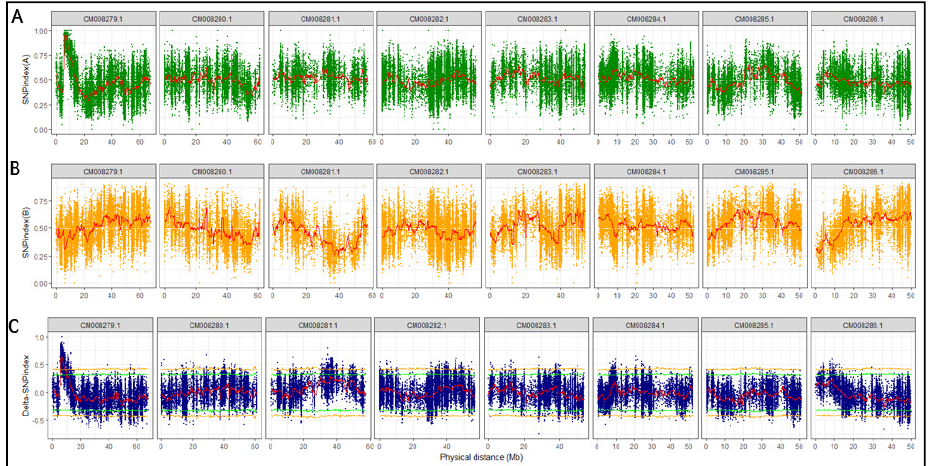
Figure 3. SNP-index plot: ( A ) the top panel is the plot of SNP-index for K21; ( B ) the middle panel is the plot of SNP-index for K5; ( C ) the bottom panel is the plot of delta SNP-index displaying the difference between A (top panel) and B (middle panel). The green and yellow horizontal lines represent thresholds for 95% and 99% confidence intervals, respectively.